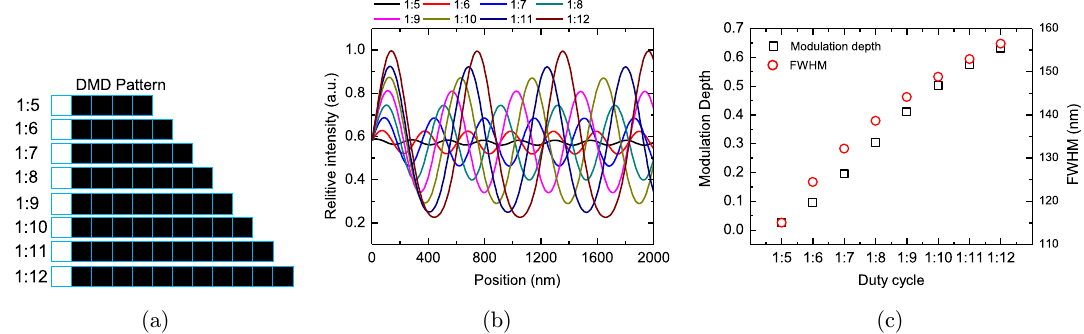
Fig. 4. Generation of sinusoidal fringe illumination with di®erent duty cycles by numerical calculation. (a) Binary patterns loaded on the DMD chip with di®erent duty cycles, (b) the normalized intensity distribution obtained in the focal plane of the objective and (c) the corresponding calculated modulation depth and resolution (FWHM) with di®erent obtained fringe